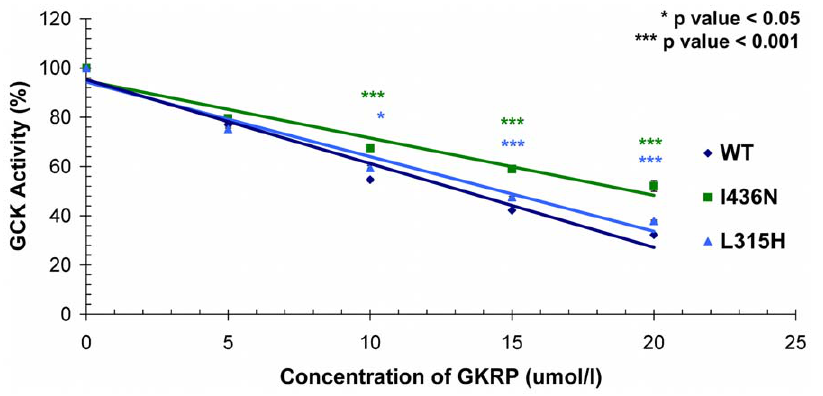
Figure 1. Inhibition of wild type, I436N and L315H glucokinase proteins by human GKRP. Data are shown as mean 6 SEM, and were obtained from 4 independent measurements. Independent t-tests were used to ascertain differences between GKRP-mediated inhibition of both mutants versus that obtained with the wild-type GCK enzyme.